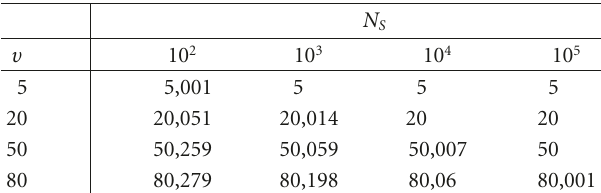
Table 1: ML estimator: mean values obtained by simulation. Re- sults obtained considering 10 4 realizations of the ML estimator.